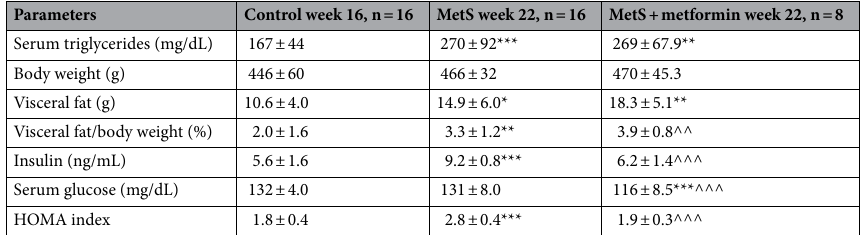
Table 1. Biochemical and biometric parameters. The controls received standard chow and tap water for 16 weeks. Metabolic syndrome (MetS) was induced by 30% sucrose in the drinking water. The parameters were measured at the end of 16 weeks and after 6 more weeks with 30% sucrose (MetS) or 30% sucrose plus metformin (100 mg/kg/day p.o., MetS + metformin). The data represent the mean ± SD. *p ≤ 0.05 vs. control, **p ≤ 0.01 vs. control, ***p ≤ 0.001 vs. control; ^p ≤ 0.05 vs. MetS, ^^p ≤ 0.01 vs. MetS, ^^^p ≤ 0.001 vs.